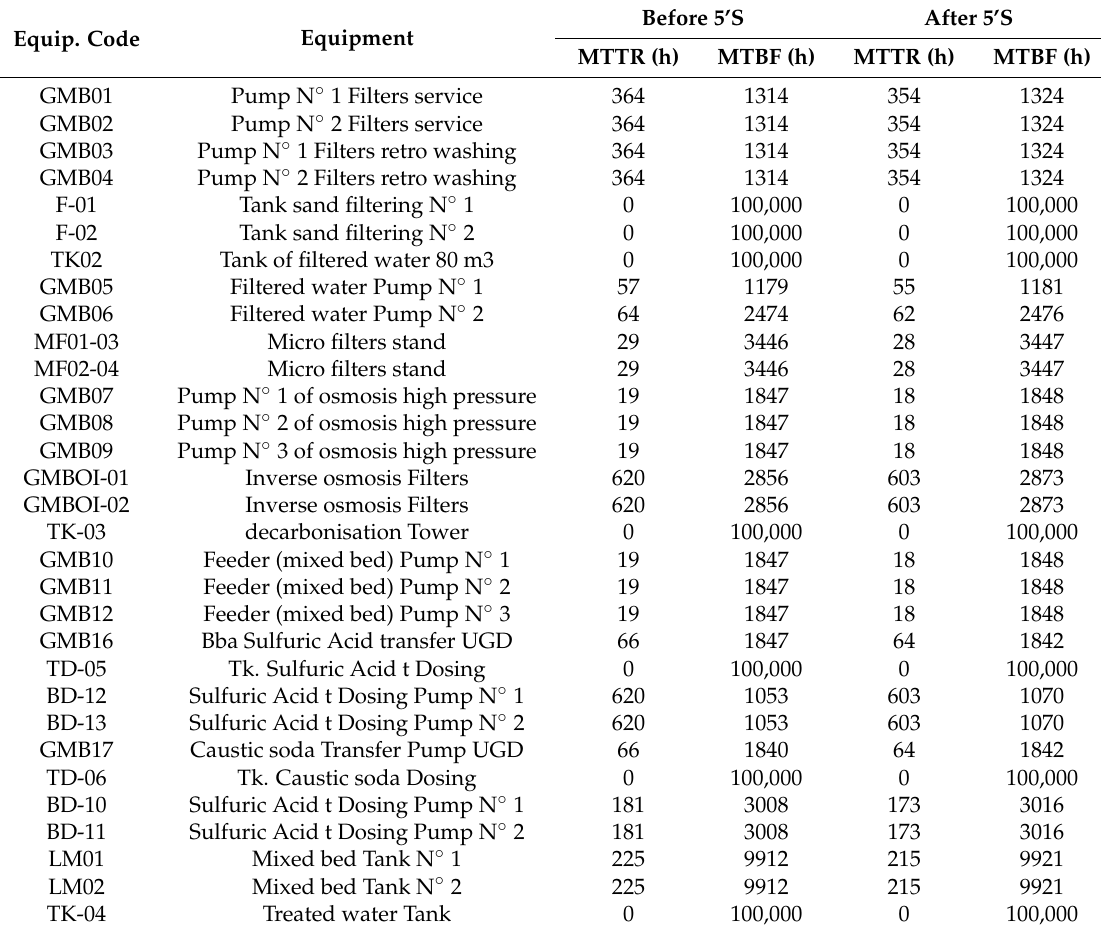
Table 5. Comparisons of operational parameters before and after applying